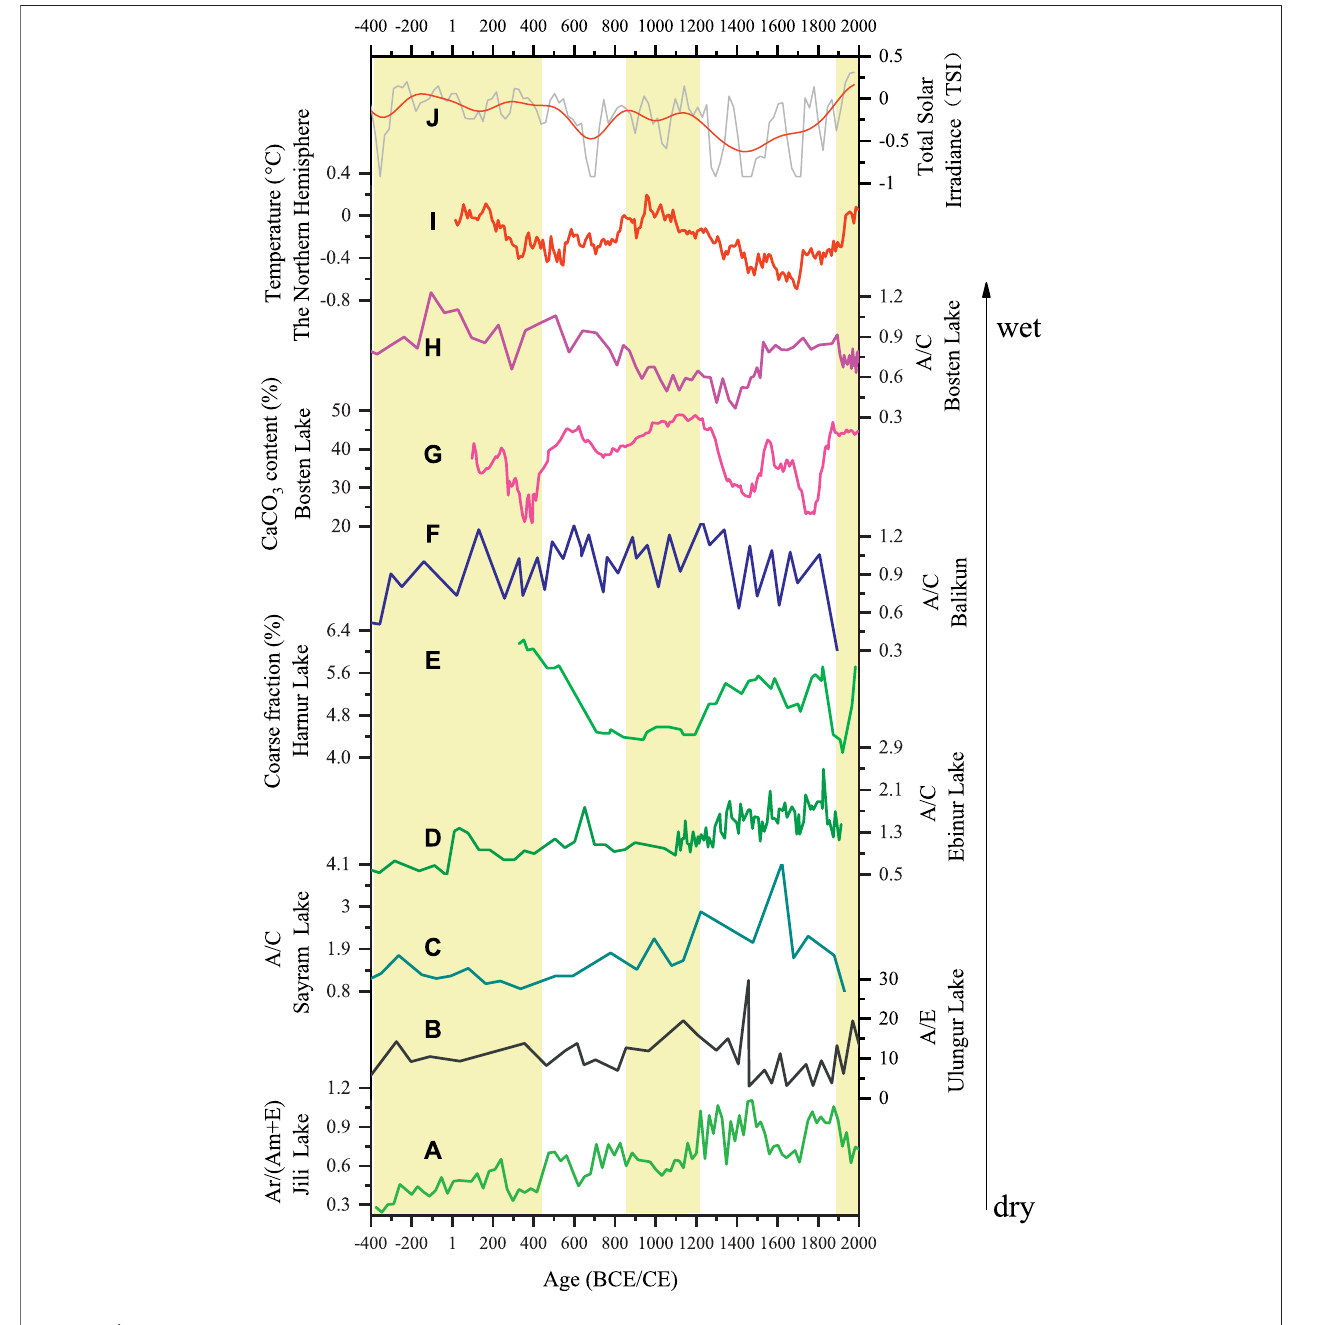
FIGURE5| Comparison ofAr/(Am +E)for thecore JL18-02-A with various paleoclimatic records: (A) Ar/(Am + E)ratio from JiliLake (this study); (B) A/E ratiofrom Ulungur Lake (Liu et al., 2008); (C) A/C ratio from Sayram Lake (Jiang et al., 2013); (D) A/C ratio from Ebinur Lake (Wang et al., 2013); (E) Coarse fraction from Harnur Lake (Lan et al., 2018); (F) A/C ratio from Balikun Lake (Tao et al., 2010); (G) CaCO 3 content from Bosten Lake (Fontana et al., 2019); (H) A/C ratio from Bosten Lake (Huang et al., 2009); (I) Temperature in the Northern Hemisphere (Ljungqvist, 2016); (J) Reconstructed Total Solar Irradiance (TSI) (Steinhilber et al., 2012).